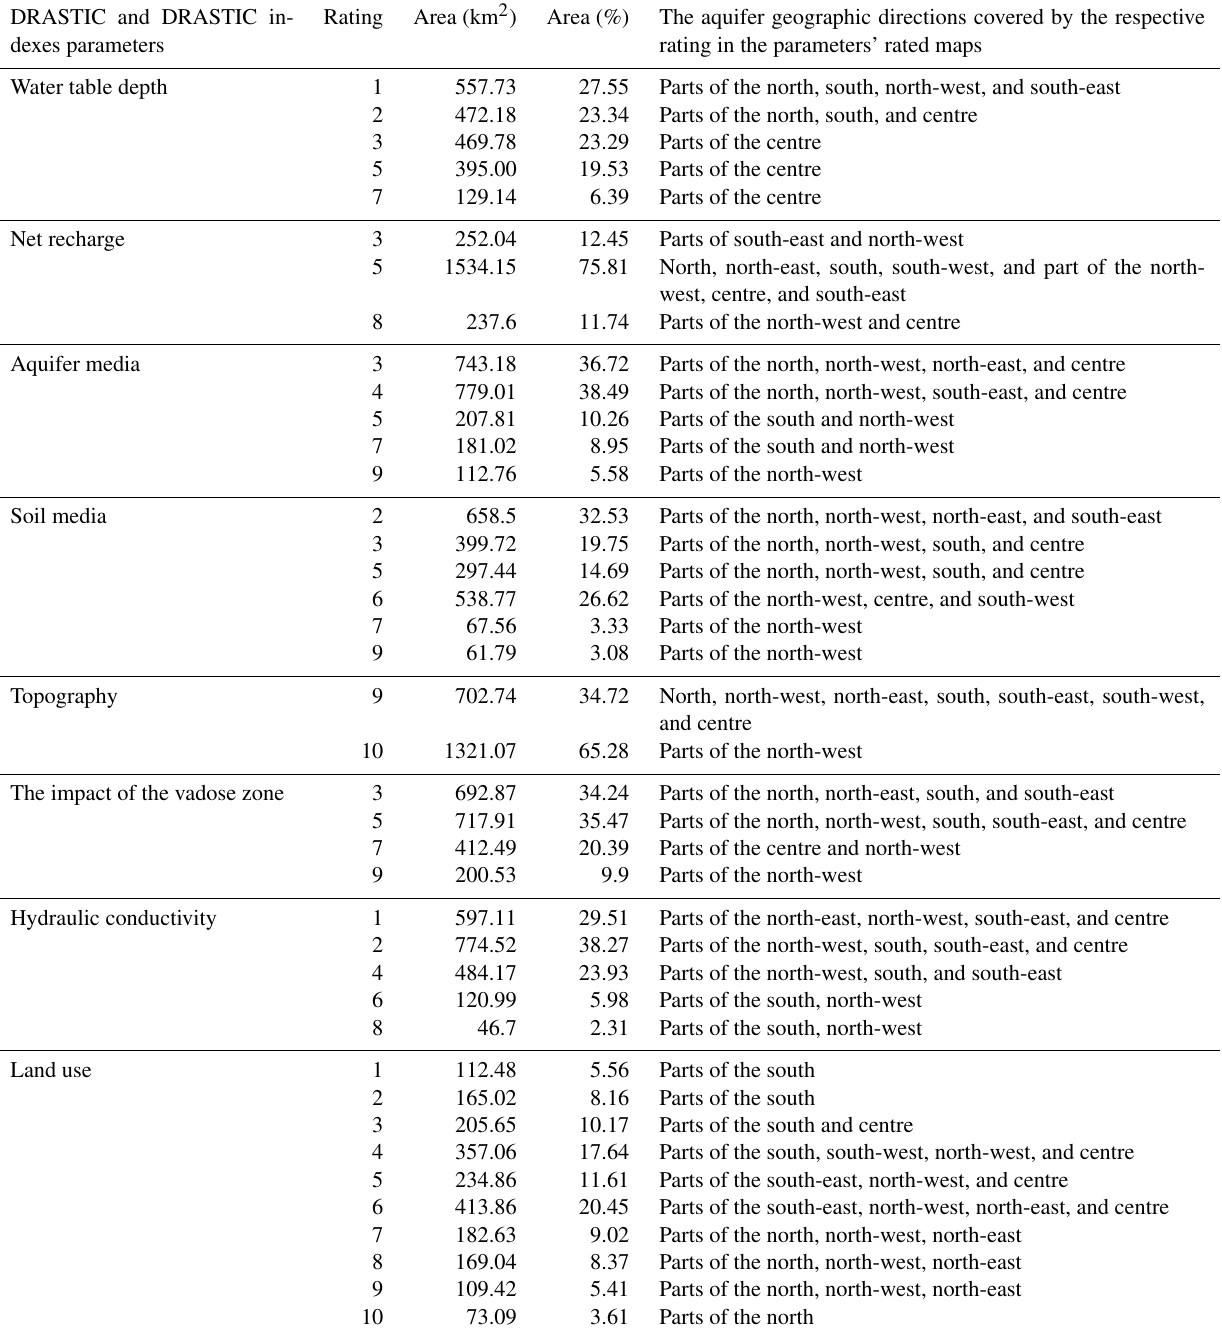
Table 6. Area of rating (square kilometres and per cent) of DRASTIC and CDRASTIC parameters. DRASTIC and DRASTIC in- Rating Area (km 2 ) Area (%) The aquifer geographic directions covered by the respective dexes parameters rating in the parameters’ rated maps Water table